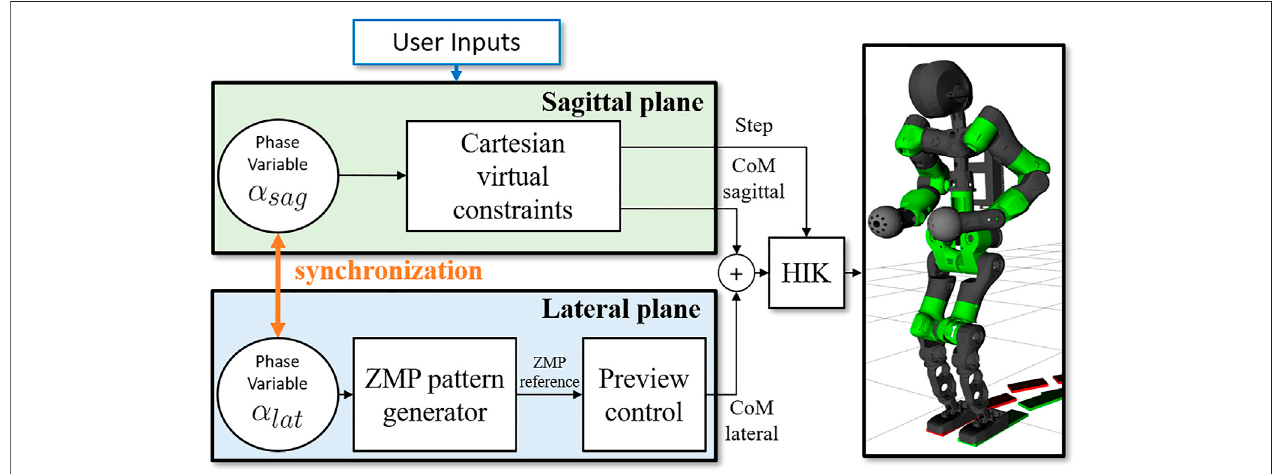
FIGURE 5 | Scheme of the proposed WPG. The sagittal and the lateral components are generated independently using the VC and the PC, based on the online user input received. The phase variables θ sag and θ lat govern the evolution of the stepping motion on the two planes, and are synchronized to obtain a feasible gait. The reference trajectories are realized by a hierarchical inverse kinematic (HIK) solver.